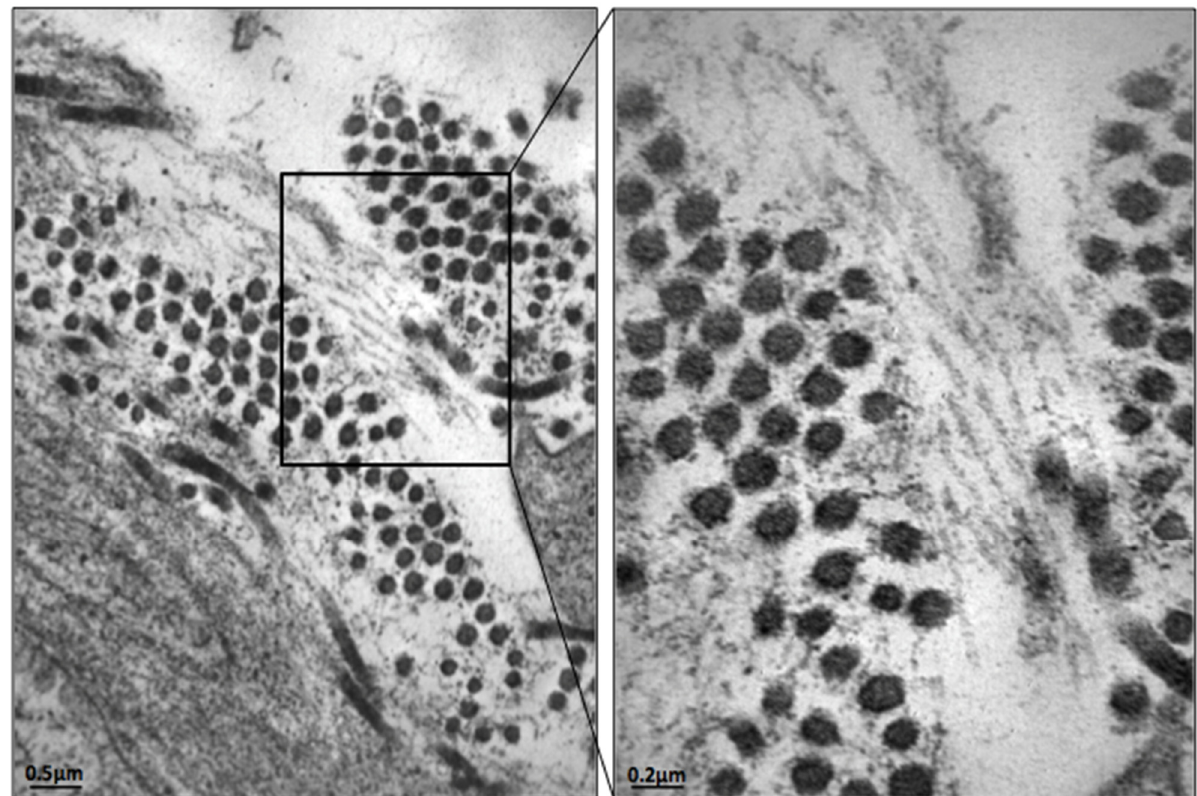
Figure 4. Periumbilical fat pad aspirate: electron microscopy image, positive for amyloid fibrils.